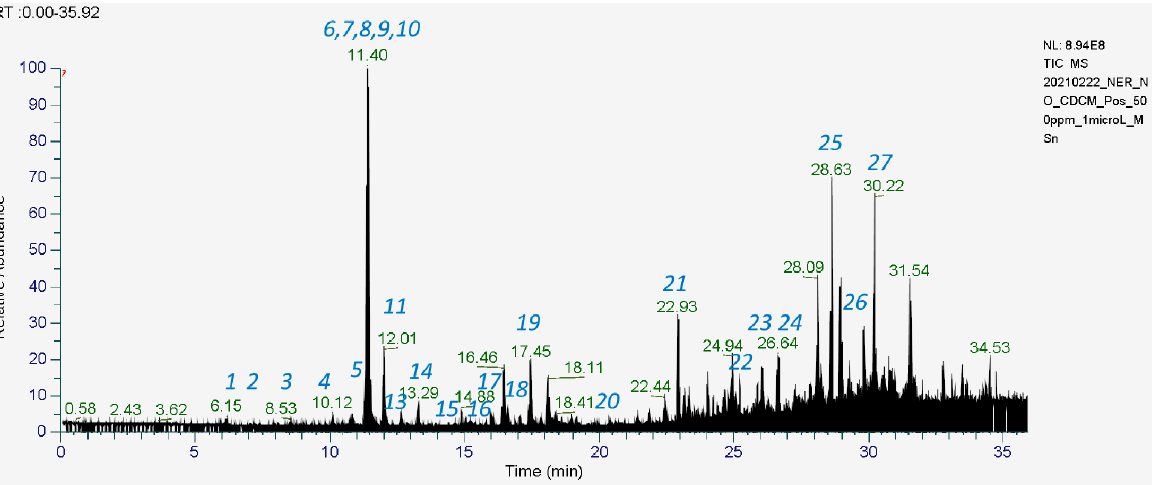
Figure 1. Dichloromethane crude extract of Ochreinauclea maingayi showing the LCMS profile under positive mode [M + H] +.